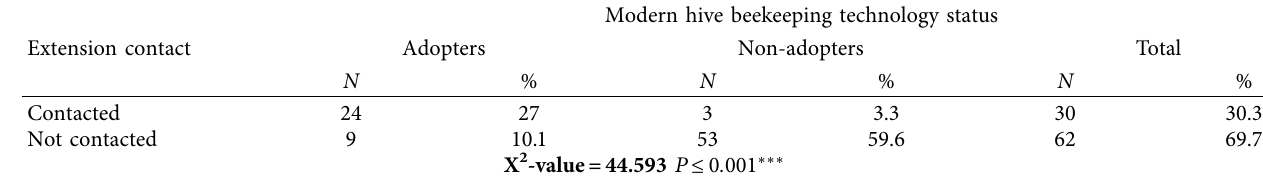
Table 10: Extension contact of beekeepers by agricultural